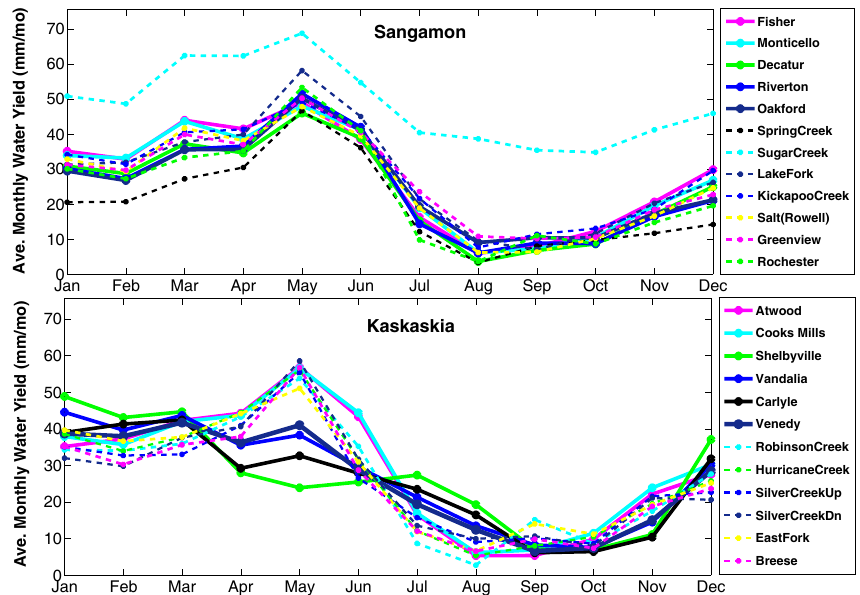
Fig. 8. Monthly regime curves for both watersheds for 1990–2011. Note that Main-stem gauges are shown as solid lines and tributary gauges are shown as dashed lines.